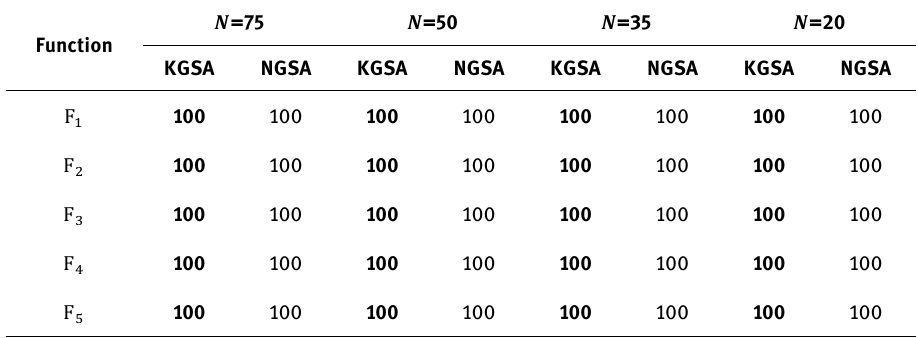
Table 4: %ADR obtained with the KGSA and NGSA using different population sizes and partitioning initialization for finding all local and global maxima.